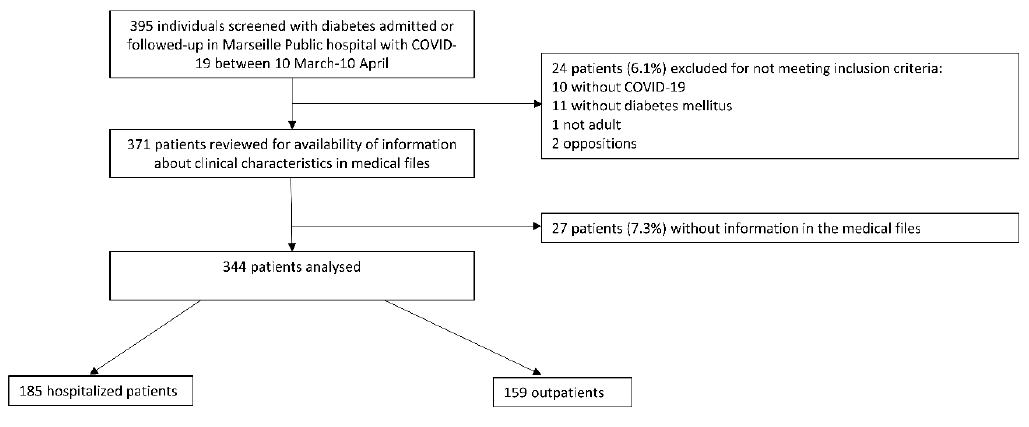
Figure 1. Study flow chart.